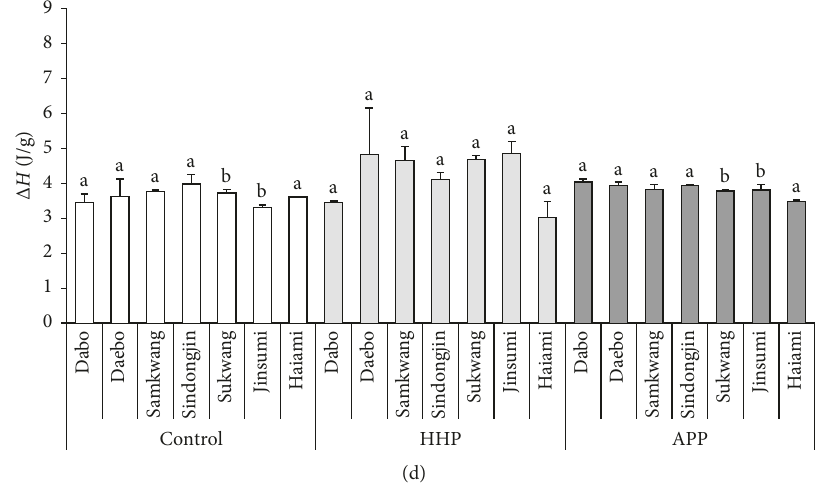
Figure 5: Differential scanning calorimetry (DSC) thermodynamic properties of rice. Samples were treated by high hydrostatic pressure or atmospheric pressure plasma, and DSC was compared to control. Values with different superscripts are significantly different at p according to Tukey’s multiple range tests within the same